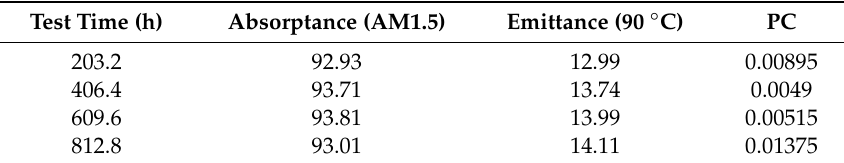
Figure 6. Optical spectrum of: ( a ) UV-Vis-NIR and ( b ) FTIR by thermal shock test. Table 2. Coating performance parameters after thermal shock test.